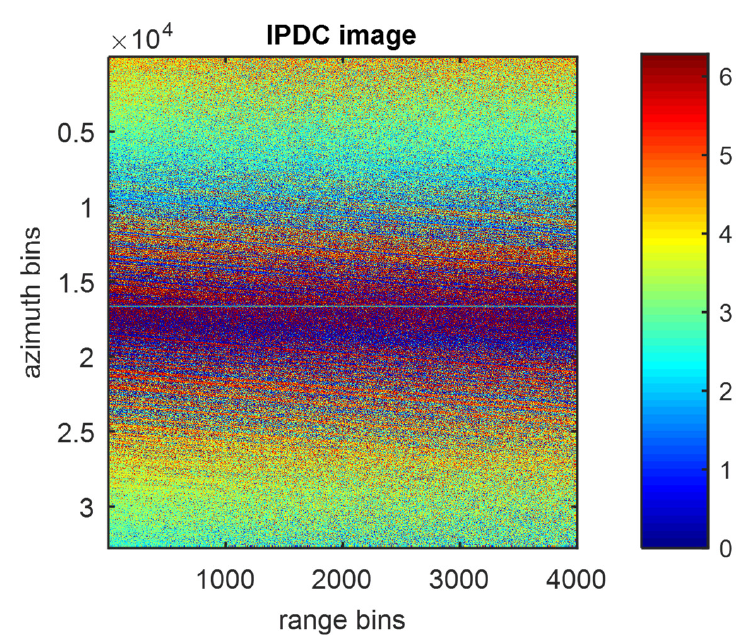
Figure 3. IPDC image of 0 dB JSR.